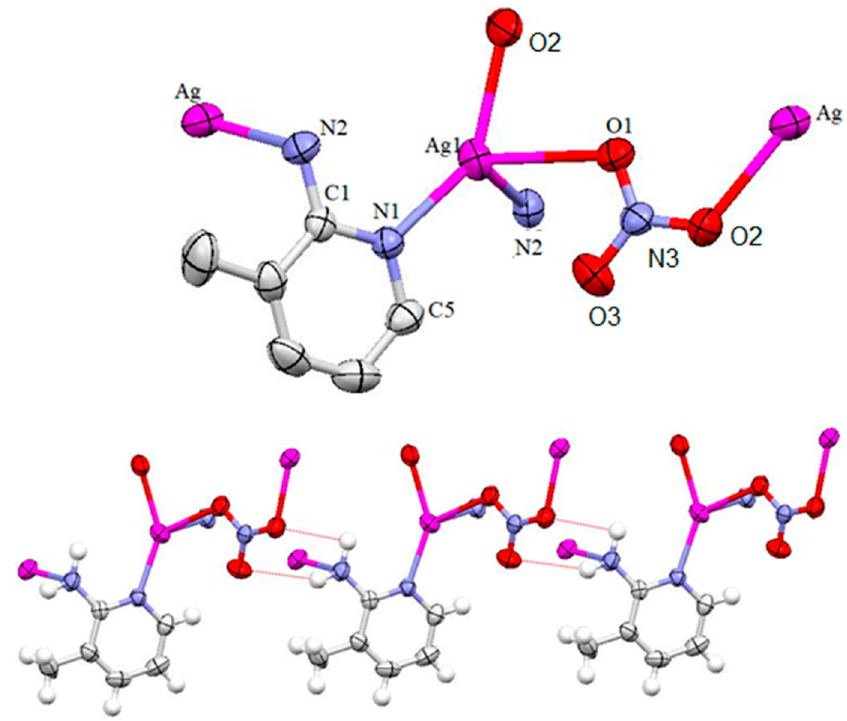
Figure 4. Solid state structure of 4 with partial atomic numbering schemes; thermal ellipsoids are drawn at 50% probability; hydrogen atoms are omitted for clarity reasons (upper structure). Intermolecular hydrogen bonding is shown in lower structure, causing extension of the structure in a 1D fashion; color scheme is the same as for complex 2